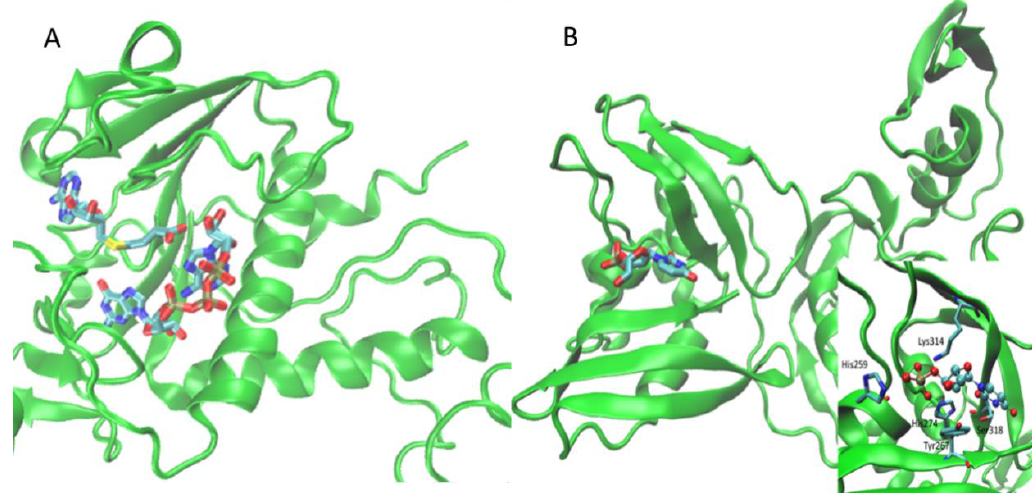
Figure 2. Identified orthosteric cavities within the nsp14 in complex with its ligands, GpppA, and SAH ( A ), as well as within the C-terminal domain of nsp15 in the putative complex with its substrate uridine 3′-phosphate (B ). In the inlet of 2B, the key contacts stabilizing the complex. Nsp16 is a 2′ O-methyltransferase [54] and two resolved structures are available in complex (PDB Id: 6W4H and 6WKS) with its cofactor nsp10, which is essential for the activity. The first structure is co-crystallized with SAM, while the second one includes both SAM and the P1-7-methylguanosine-P3-adenosine-5′,5′-triphosphate (GTA) substrate, thus allowing precise identification of the overall catalytic pocket.